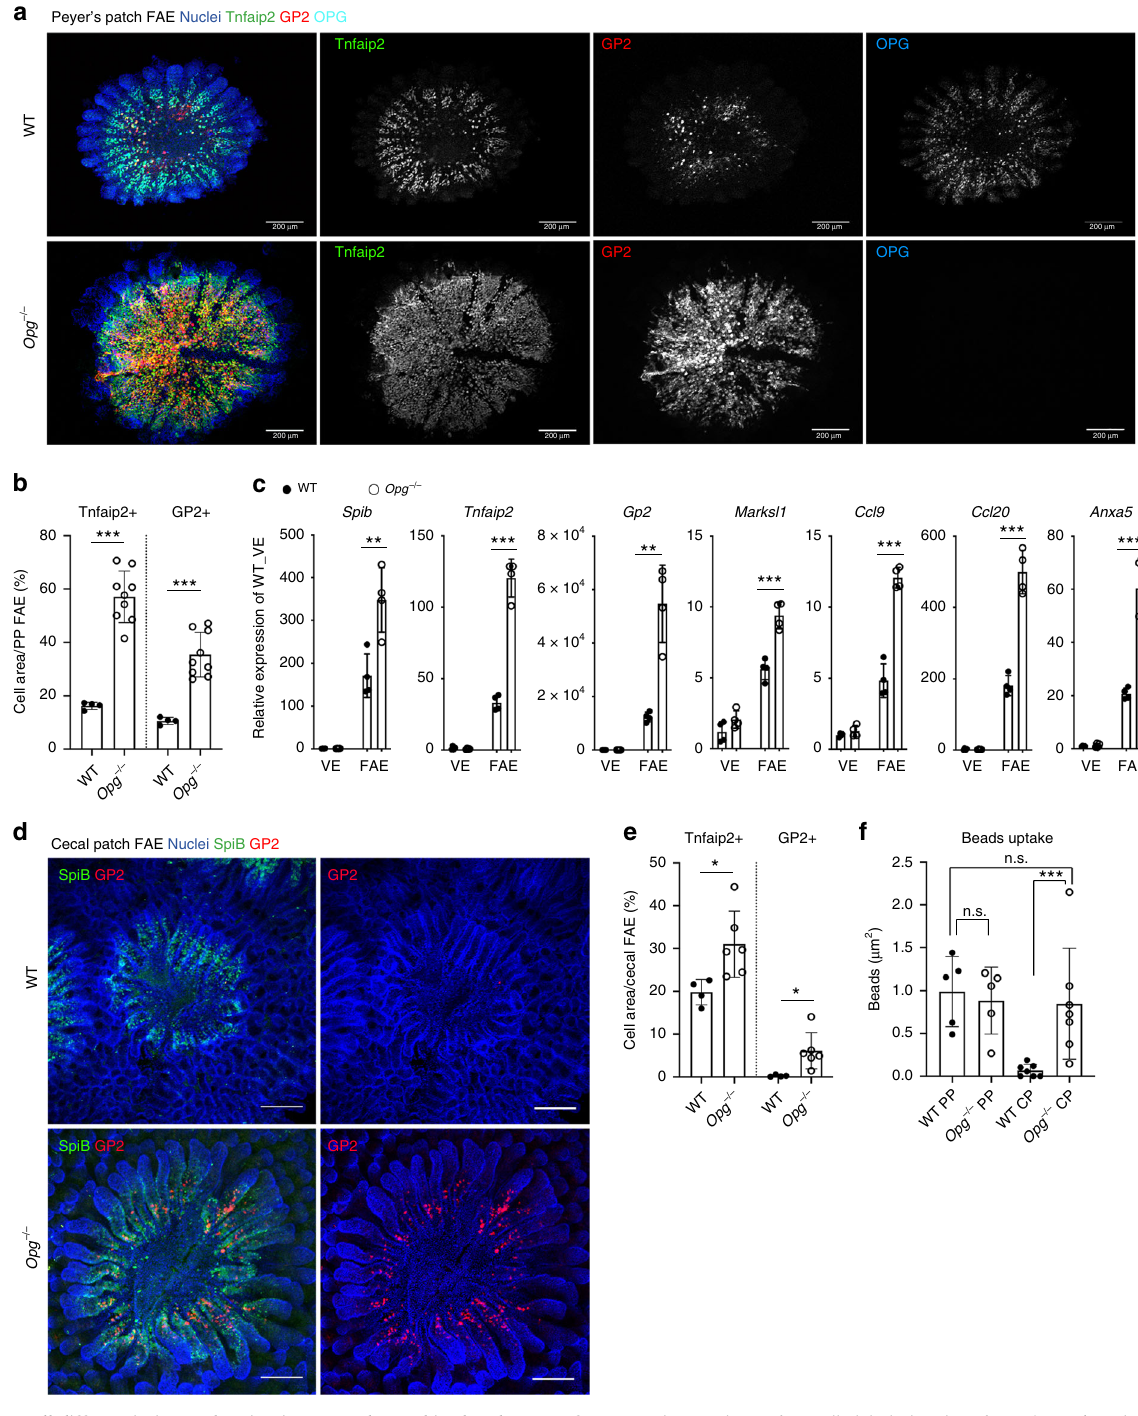
Fig. 2 M-cell differentiation and activation are enhanced in the absence of OPG. a The numbers of M cells labeled with Tnfaip2 (green) and GP2 (red) are prominently increased in the follicle-associated epithelium (FAE) of Payer ’ s patches from Opg − / − mice. Each indicated channel is shown separately in gray scale. Scale bars: 200 µ m. b The numbers of Tnfaip2-positive or GP2-positive M cells in the FAE of Peyer ’ s patches from WT and Opg − / − mice were quanti fi ed. Values are presented as the mean ± standard deviation. *** p < 0.005 (Student ’ s t -test, n = 4 of WT and 9 of Opg − / − mice). c The expression levels of M cell-associated genes in the FAE of Peyer ’ s patches were normalized to Gapdh expression and are presented relative to the expression in the villus epithelium (VE). Values are presented as the mean ± standard deviation. ** p < 0.01, *** p < 0.005 (Student ’ s t -test, n = 4 animals). d Whole-mount staining images of GP2 (red), Spi-B (green), and DAPI (blue) in cecal FAE. Scale bars: 100 µ m. e The numbers of Tnfaip2-positive or GP2-positive M cells in the FAE of cecal patches from WT and Opg − / − mice were quanti fi ed. Values are presented as the mean ± standard deviation. * p < 0.05 (Student ’ s t-test, n = 4 of WT and 9 of Opg − / − mice). f The uptake of latex beads into Peyer ’ s patches and cecal patches was measured. Data from three independent experiments are presented as the mean ± standard deviation. *** p < 0.005. n.s. not signi fi cant (Student ’ s t -test, n = 7 animals). The source data underlying panels b , c , e and f are provided as a Source Data fi